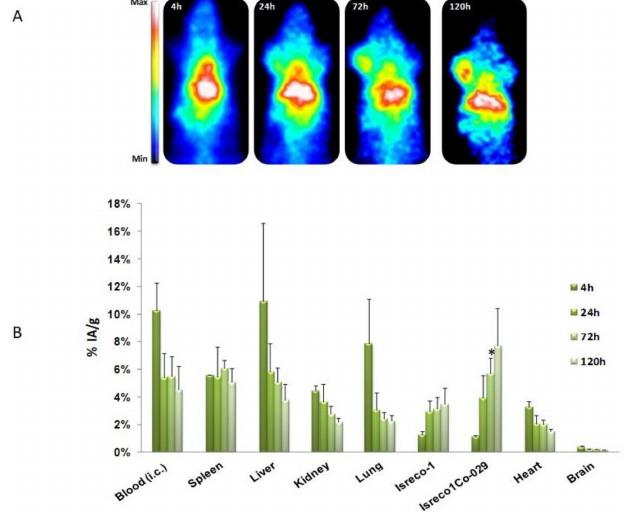
Figure 4. In-vivo specificity of [ 111 In]DOTA-Ts29.2 for Tspan8-expressing tumors. Nude NMRI mice with Isreco-1 (left shoulder) and Is1-Co29 (right shoulder) were injected (i.v.) with 3.7 MBq of [ 111 In]DOTA-Ts29.2 and imaged with a planar γ -camera at 4 h, 24 h, 72 h and 120 h post injection ( A ). Ex-vivo biodistribution study (%AI/g) of [ 111 In]DOTA-Ts29.2 ( B ) was determined on the same mice with the same protocol as Figure 3B. Biodistribution difference between the two tumors: * p < 0.05. Fisher